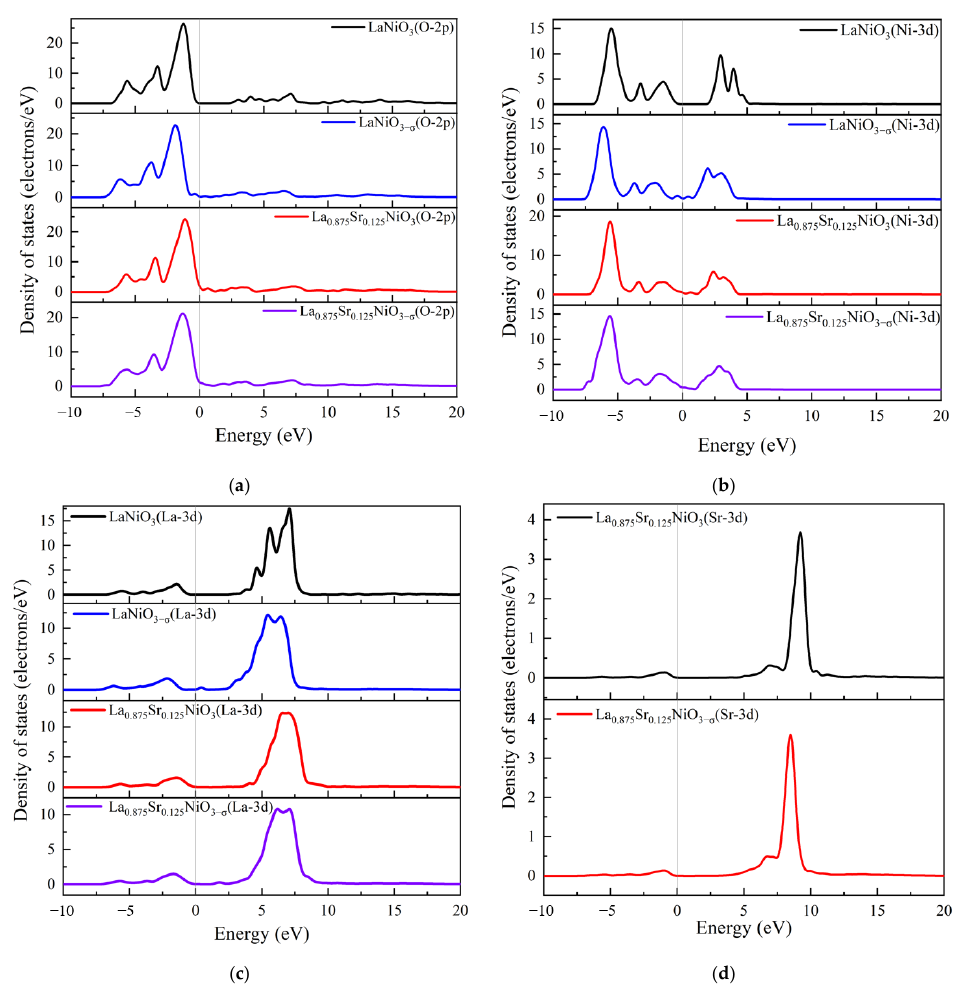
Figure 11. Partial density of states. ( a ) O-2p; ( b ) Ni-3d; ( c ) La-3d; ( d ) Sr-3d.